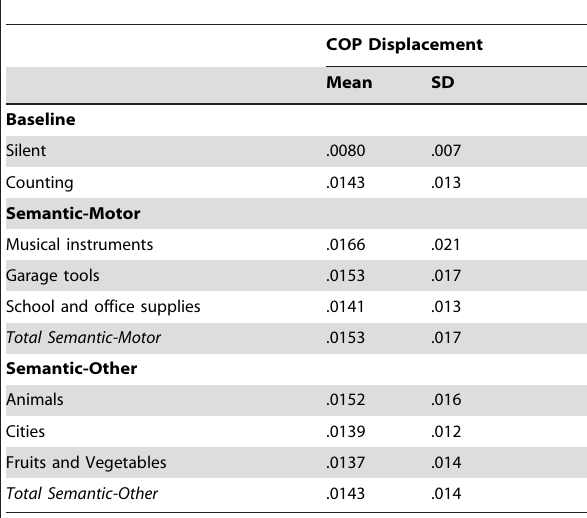
Table 1. COP Displacement Means by Semantic